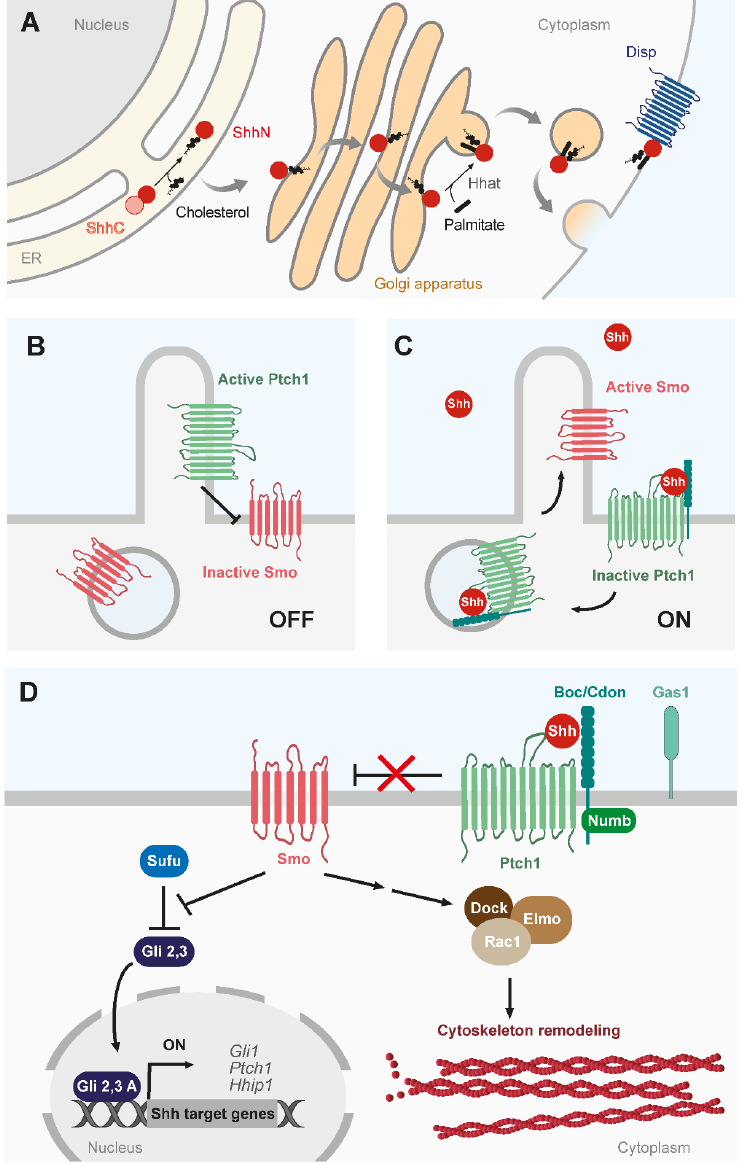
Figure 1. Shh signaling pathway. ( A ) Shh precursor is cleaved in the endoplasmic reticulum (ER). While the C-terminal part is discarded, the N-terminal part will be modified by the addition of a cholesterol molecule. Later, a palmitate is added to the peptide via the Hedgehog acyltransferase (Hhat). Finally, Shh is addressed to the plasma membrane where it interacts with Dispatched to initiate its secretion. ( B ) In the absence of Shh ligand, Ptch1 is localized at the primary cilium and inhibits the activity of Smo. ( C ) Upon Shh binding to its receptor Ptch1, Smo is activated and translocate to the primary cilium while ligand/receptors complexes are internalized. ( D ) Canonical pathway activation represses the sequestration of Gli2/3 in the cytoplasm by Suppressor of Fused (SUFU), allowing the transcription of Shh target genes. Shh pathway activation can also promote cytoskeleton remodeling downstream of Smo through the Elmo/Dock complex and Rac1 phosphorylation. The endocytic adaptor Numb is required for Boc endocytosis and Shh-mediated axon attraction. See main text for details. Shh, Sonic hedgehog; Ptch1, Patched 1; Smo, Smoothened; Cdon, Cell adhesion associated oncogene regulated protein; Boc, Brother of Cdon; Gas1, Growth-arrest specific gene 1; Suppressor of Fused, SUFU; Glioma-associated oncogene, Gli; Hedgehog interacting protein 1, Hhip1; Engulfment and Cell Motility, ELMO; Rac Family Small GTPase 1, Rac1; Dedicator of cytokinesis protein,